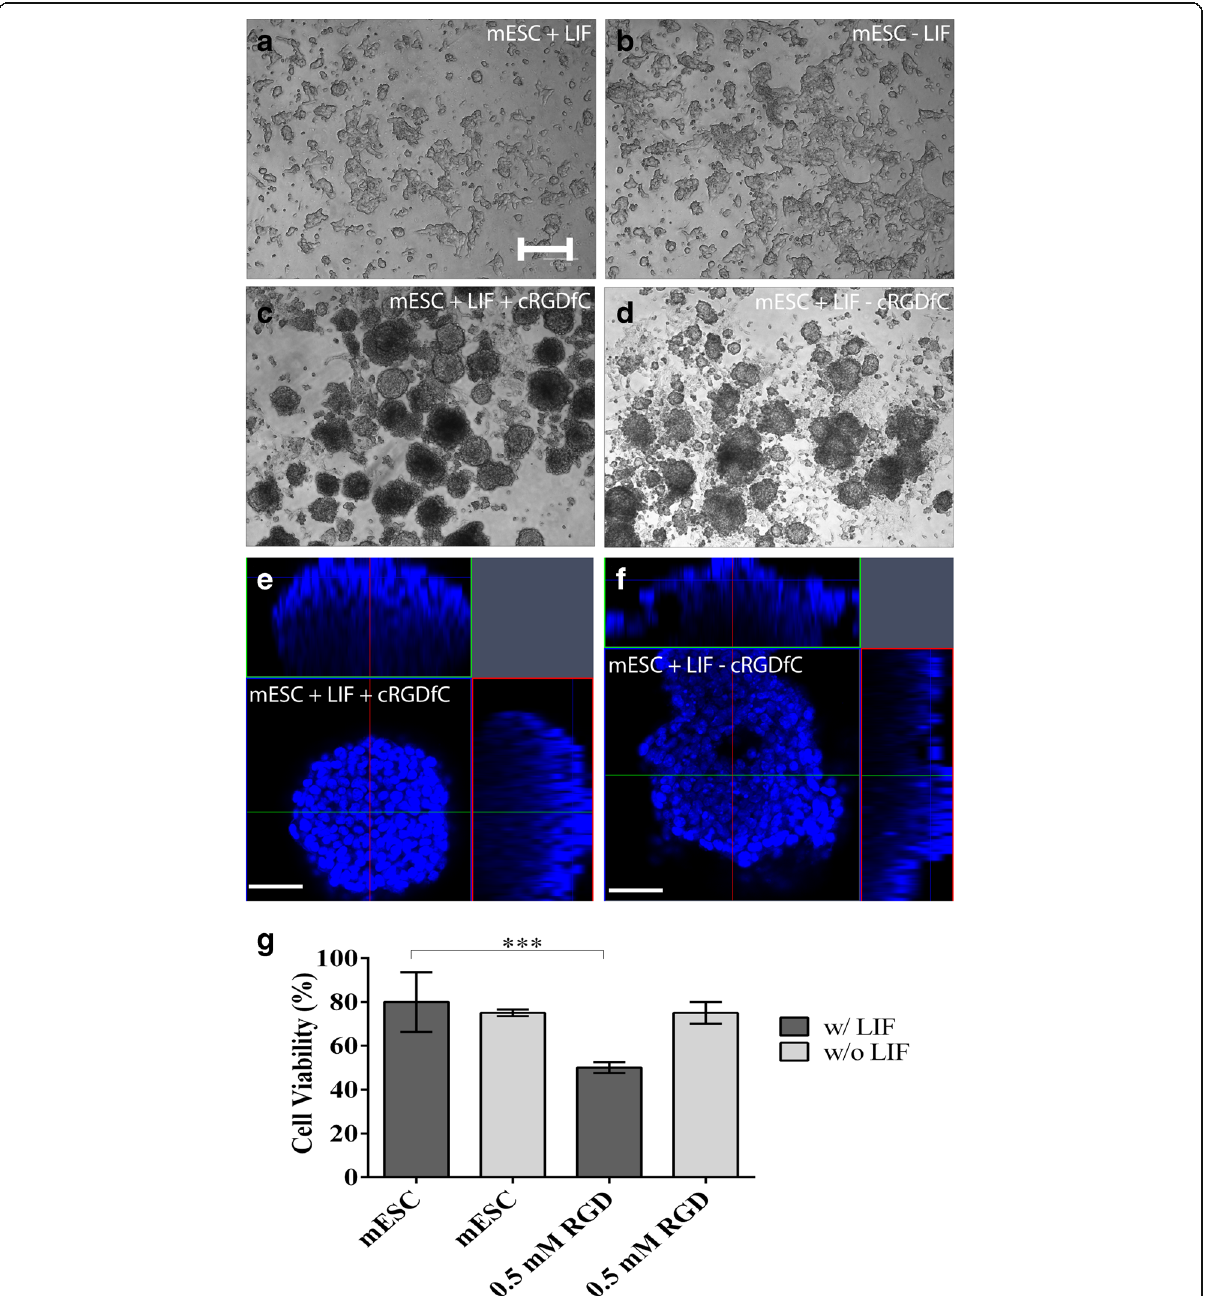
Fig. 3 Effect of cRGDfC peptide on mESC morphology and viability when cultured in a dish without the presence of collagen matrix. ( a ) mESC with LIF and ( b ) mESC without LIF remained attached and showed no visible differences in cell morphology; ( c ) mESC with LIF + cRGDfC and ( d ) mESC without LIF + cRGDfC formed round shaped aggregates and detached from the dish. Scale bar, 200 μ m. The morphology of aggregates formed in the presence ( e ) or absence ( f ) of LIF was also examined using DAPI staining with 3D confocal imaging and reconstruction. Scale bar, 100 μ m. ( g ) Cell viability significantly decreased in the presence of LIF and cRGDfC to 50% in comparison to mESC